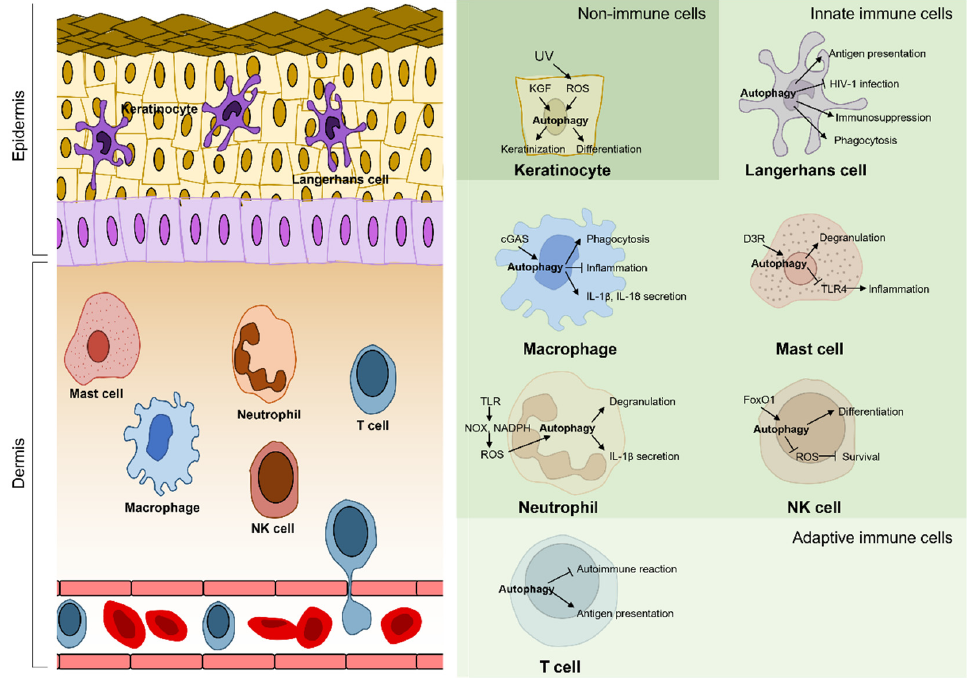
Figure 2. Population of immune-related cells in the skin. Keratinocytes are the main component of the epidermis. In the process of acting as the first skin barrier, keratinocytes also participate in immune-related responses. Under normal conditions, Langerhans cells, macrophages, mast cells, and T cells constitute the skin-resident immune system, which induces a rapid innate response. Upon activation of the immune system, additional immune cells, such as neutrophils, NK cells, and T cells, are recruited to the skin to aid the immune responses. Autophagy occurs actively in the skin because numerous stressors that activate autophagy are applied to the skin. Autophagy supports the skin barrier by mediating the function of the immune-related cells. Cell-type-specific pathways are de- scribed in detail in the text and figure.